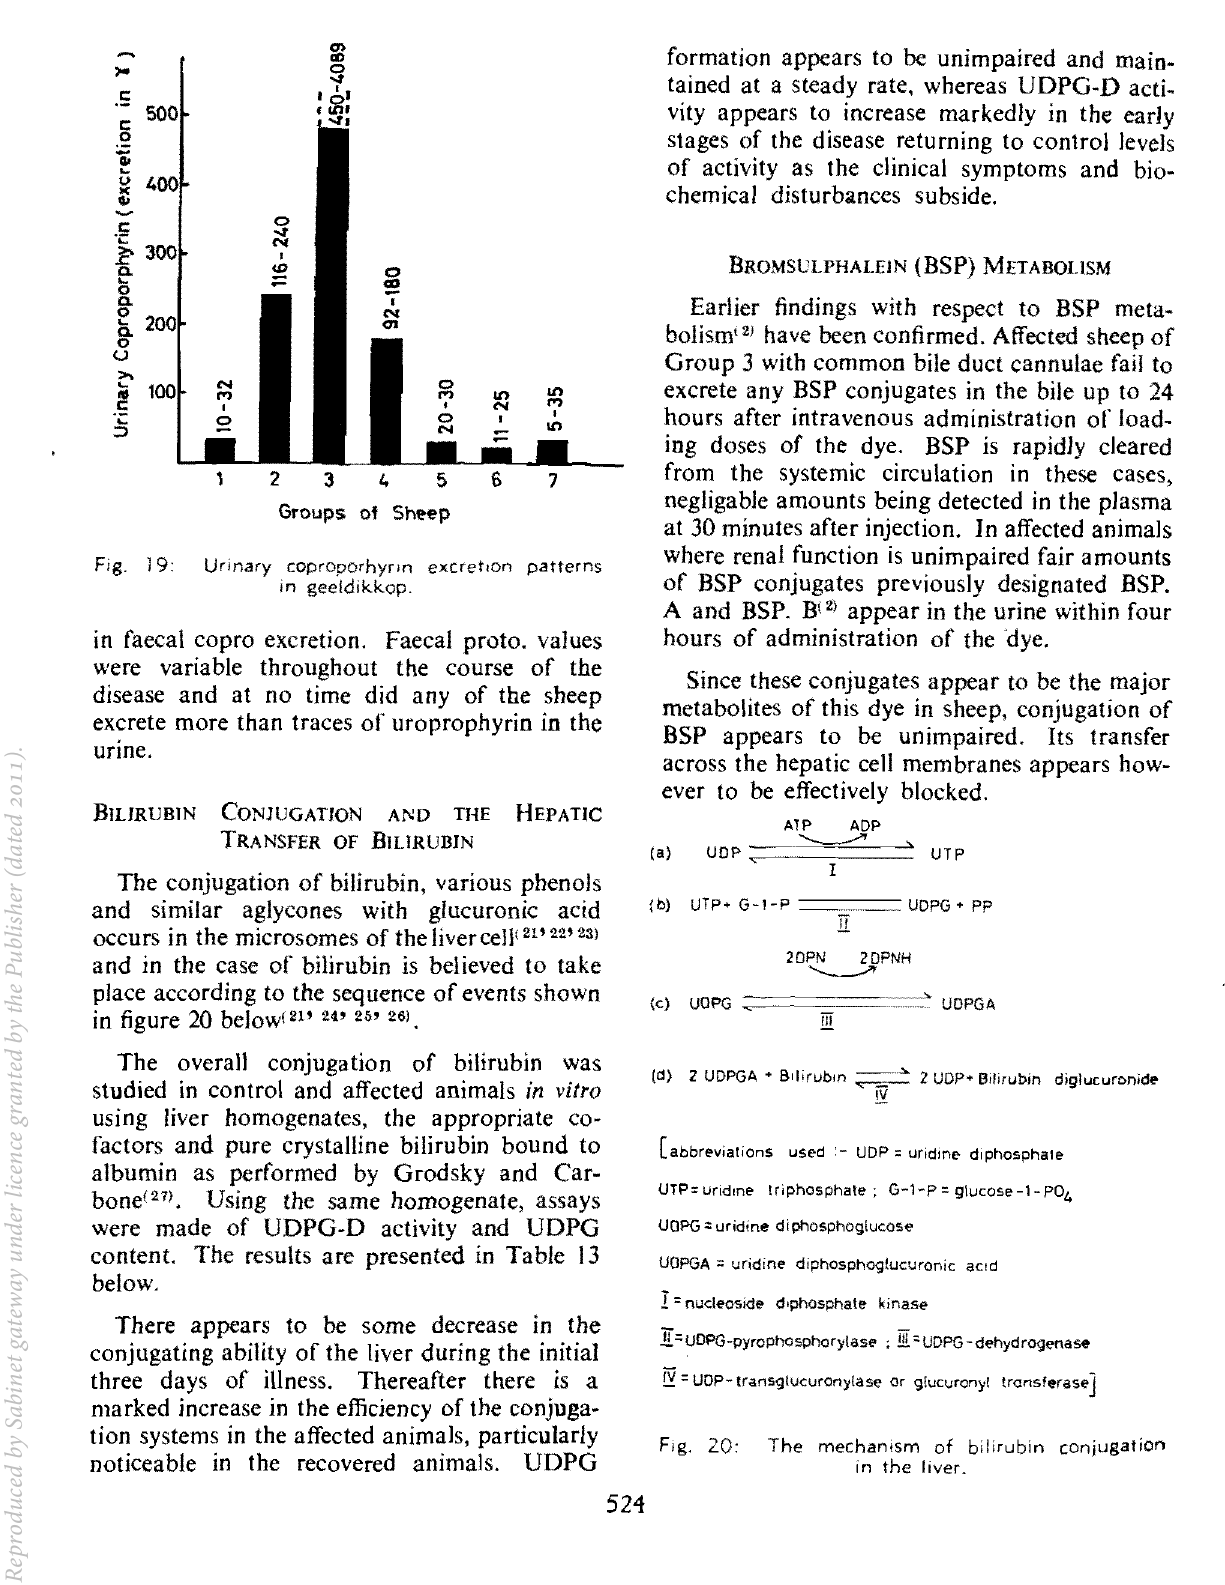
Urinary coproporhynn excretion patterns in geeldikkop. in faecal copro excretion. Faecal proto. values